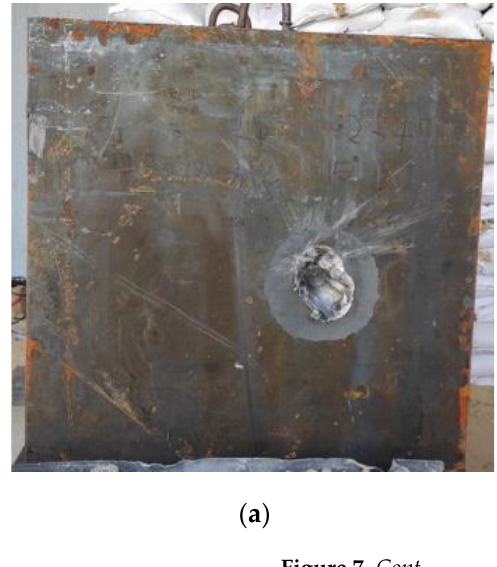
( d ) Figure 7. Typical appearance of craters of a 30 － mm ogive － shaped steel projectile obliquely pene- trating a 90 － mm steel target plate at different striking velocities and obliquities: ( a ) 789 m/s, 15° obliquity; ( b ) 570 m/s, 25° obliquity; ( c ) 315 m/s, 30° obliquity and ( d ) 407 m/s, 45° obliquity.